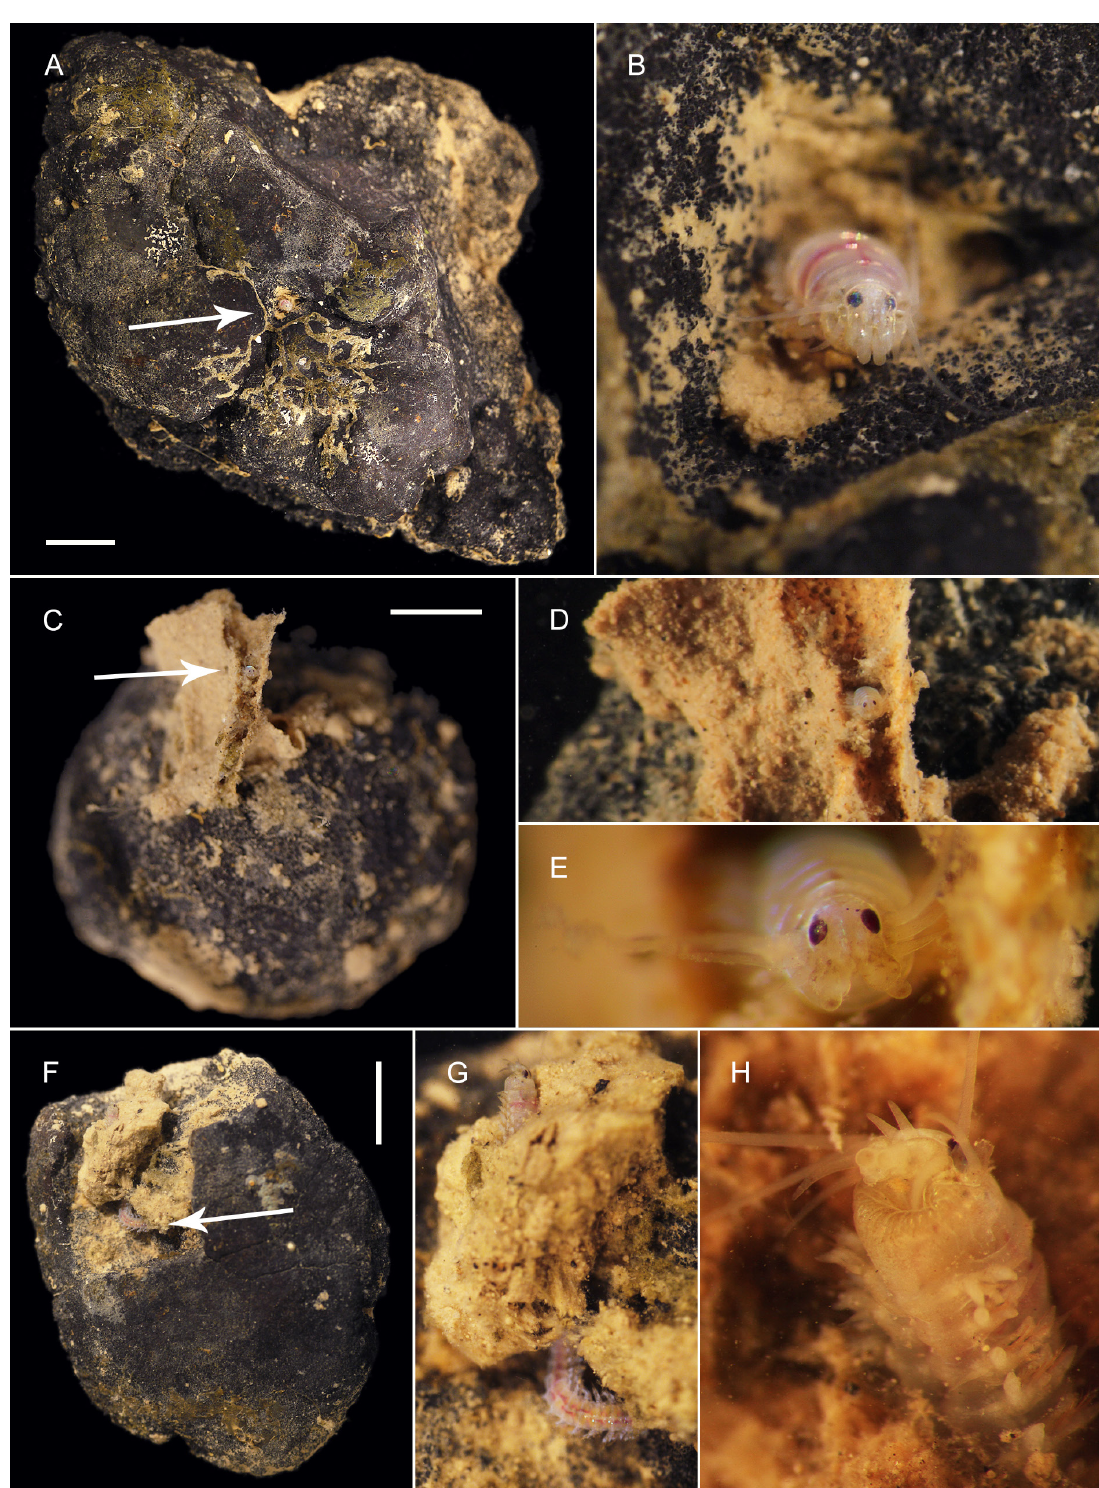
Fig. 8. Neanthes goodayi sp. nov., live specimens, in situ images. A . Paratype (NHM_2026), burrowing within nodule crevice. B . Detail of paratype (NHM_2026), in burrow. C . Paratype (NHM_512), burrowing within a foraminiferan growing on nodule. D–E . Detail of paratype (NHM_512), in burrow. F . Detail of paratype (NHM_1624), burrowing within a mudball encrusting the nodule surface. G–H . Details of paratype (NHM_1624), in burrow. Scale bars: 1